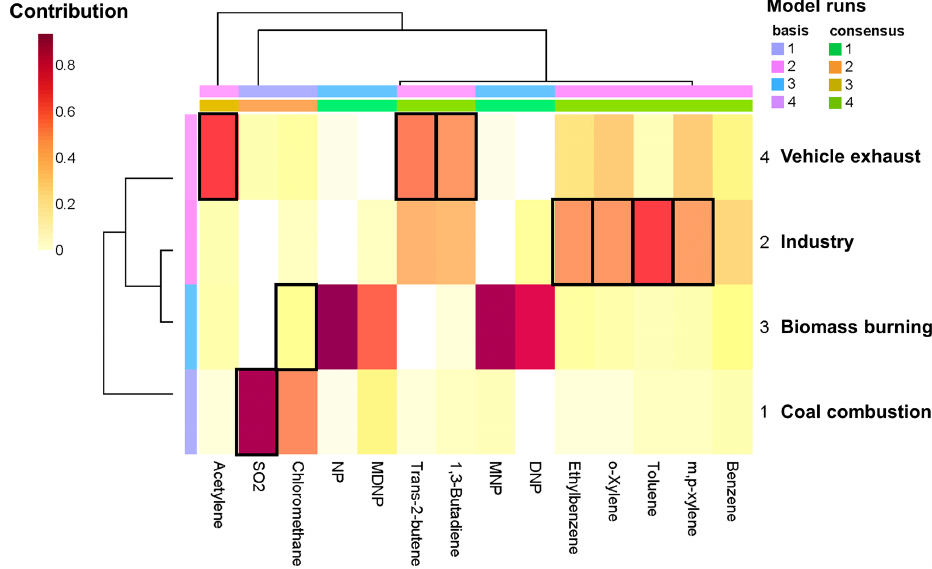
Figure 7. Mixture coefficients of the Kullback–Leibler (KL) algorithm with four factors by non-negative matrix factorization (NMF). Factor 1: coal combustion; factor 2: industry (pesticide); factor 3: biomass burning; factor 4: vehicle exhaust. “Basis” and “consensus” in the legend were the model runs, and the results are displayed in the heatmap.